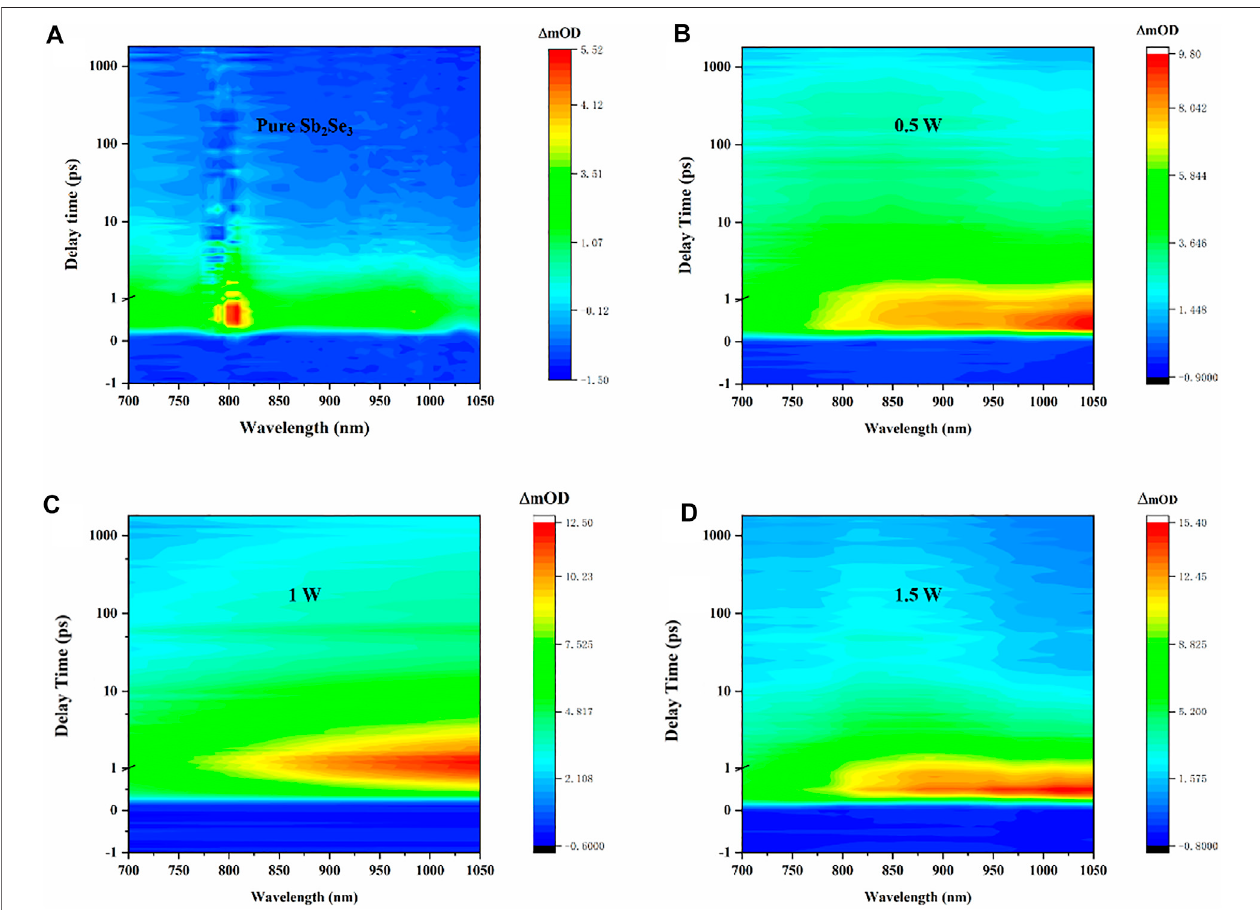
FIGURE 8 | (A) The results of the transient absorption experiment of the pure Sb 2 Se 3 nano fi lm at near infrared. (C – D) The results of the transient absorption experiment of Co-doped